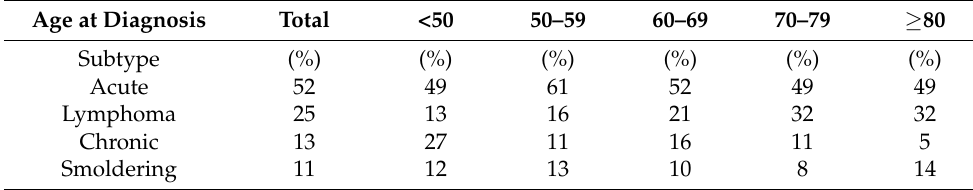
Table 7. Age at diagnosis and clinical